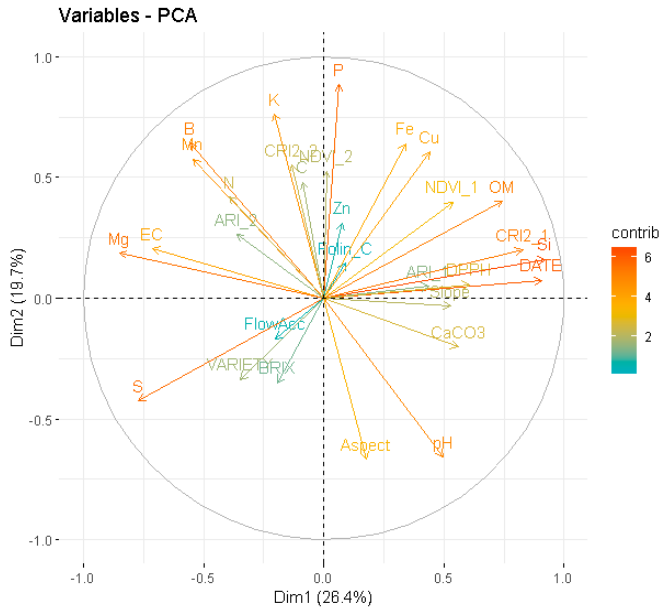
Figure 4. Principal component analysis (PCA) for the soil, fruit quality, remote sensing and topographic data affecting the cherry fruit free radical scavenging activity (DPPH).